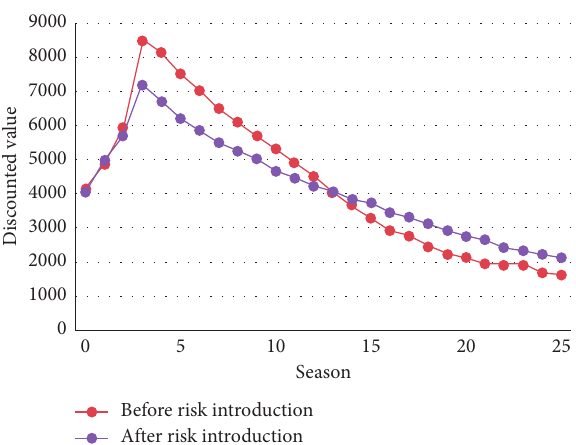
Figure 7: Seasonal discounted value curves before and after risk